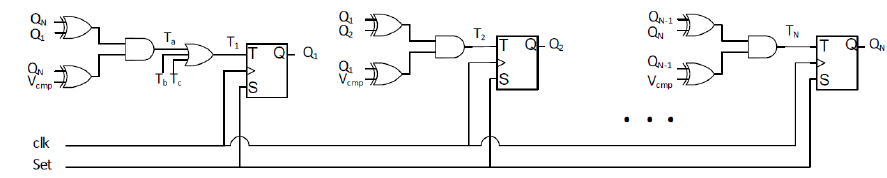
Figure 2. Schematic of the shift register utilized in the DLDO as used in [26,27].